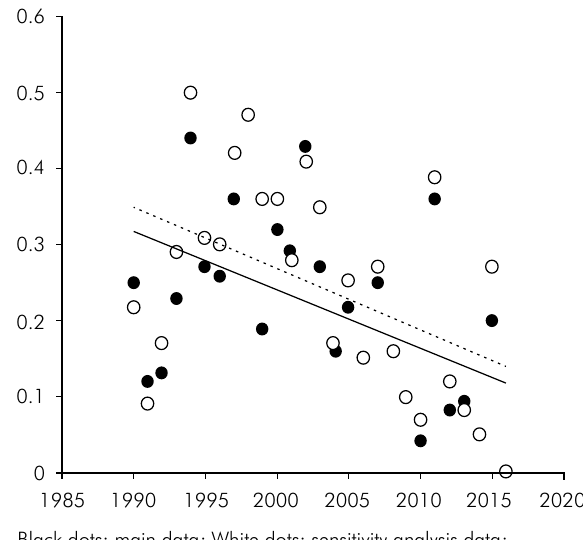
Black dots: main data; White dots: sensitivity analysis data; Solid line: trend line, main data (coefficient = -0.007, p = 0.01); Broken line: trend line, sensitivity analysis data (coefficient = -0.008, p = 0.01). Figure 2. Ratio of number of reports from uncontrolled to controlled trials per